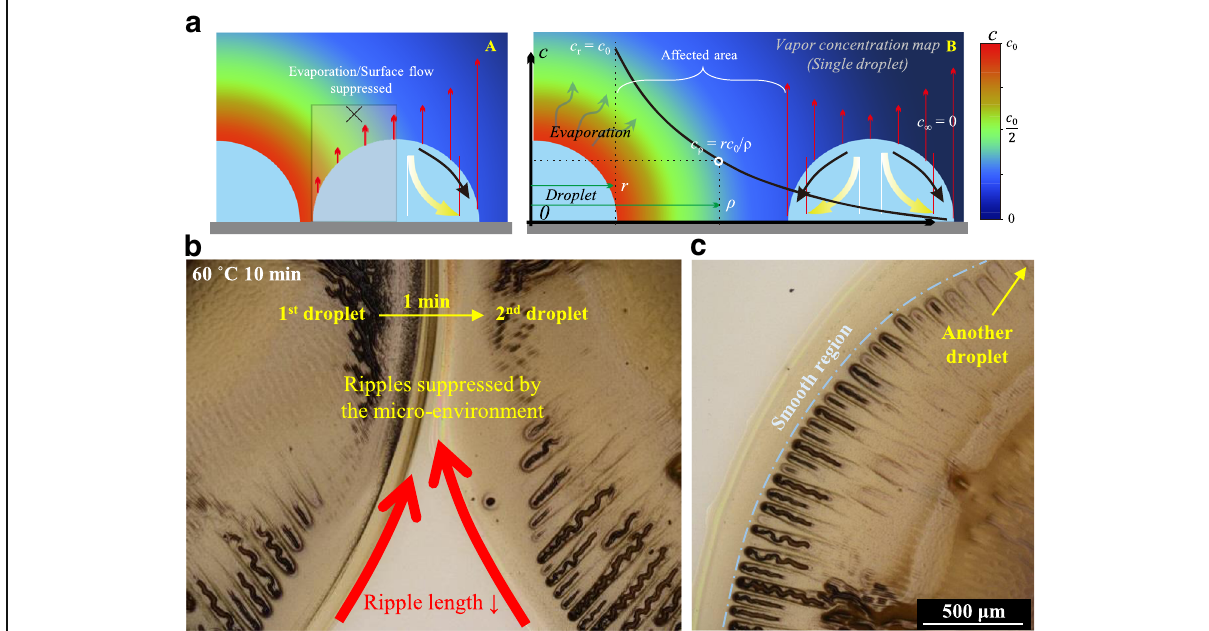
Fig. 3 Zigzag hollow cracks regulated by its drying micro-environment. a Color map of the drying micro-environment based on the simplest vapor diffusion model. b Effect of the drying micro-environment on two subsequently released droplets with a short distance. c Ripples change from the nearest region to the farther region of two neighboring